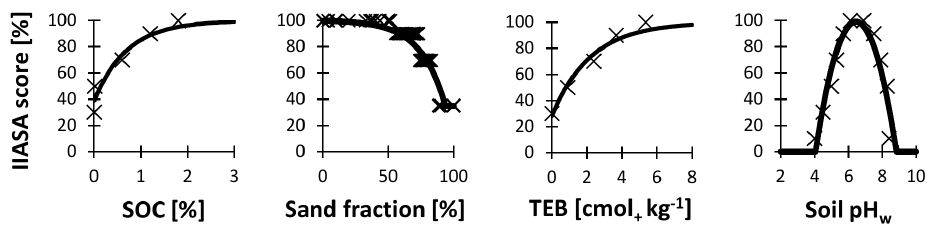
Figure 1. IIASA soil scores for soil organic carbon concentration (SOC), texture, total exchangeable bases (TEB), and pH measured in water (pH w ). The curves were drawn based on approximate functions through the points, which were derived from crop-specific scores in a lookup table (http://webarchive.iiasa.ac.at/Research/LUC/GAEZv3.0/soil_evaluation.html; last access: 7 June 2018, IIASA and FAO, 2012) and averaged over all crop species in the table. Table 1. Overview of variables of the database used in the current study. Each plot for soil and vegetation analyses had a 10m radius and was sampled once during the period 2003–2012. The (mostly managed) forests in the inventory represent a random sample of Swedish forests. Abbreviations: MAP: mean annual precipitation; TSUM: growing season temperature sum; SOC: soil organic carbon concentration; TEB: total exchangeable bases; pH w : pH measured in water; pH KCl : pH measured in KCl solution; TN: total nitrogen concentration; soil C:N ratio: soil carbon-to-nitrogen